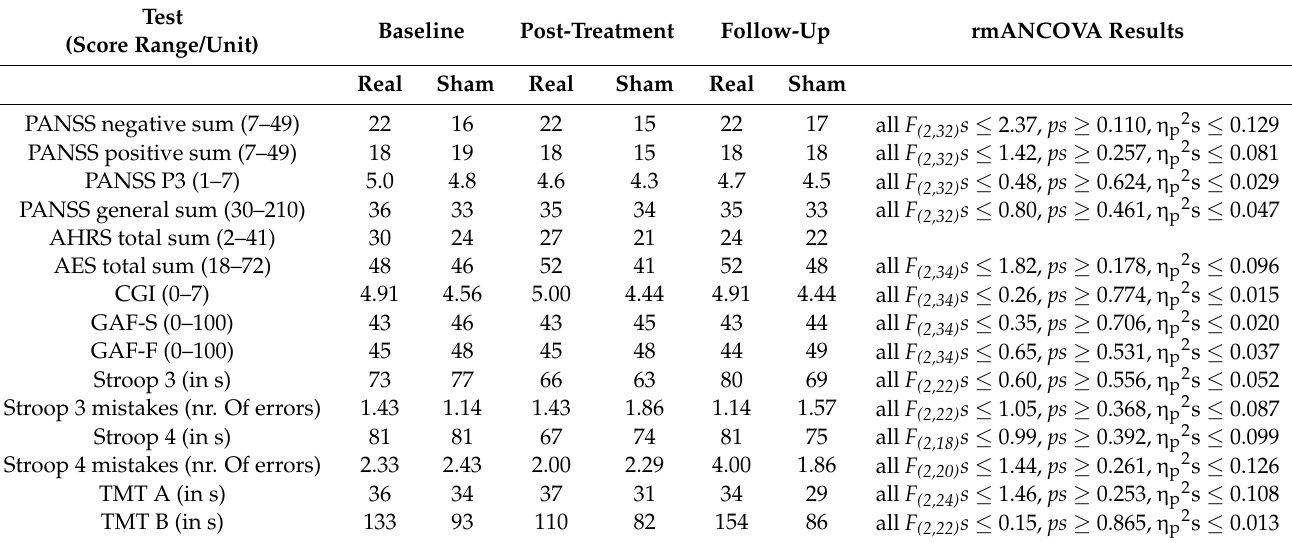
Table 3. Mean scores for all clinical and neurocognitive/general functioning tools for real and sham participants at all time